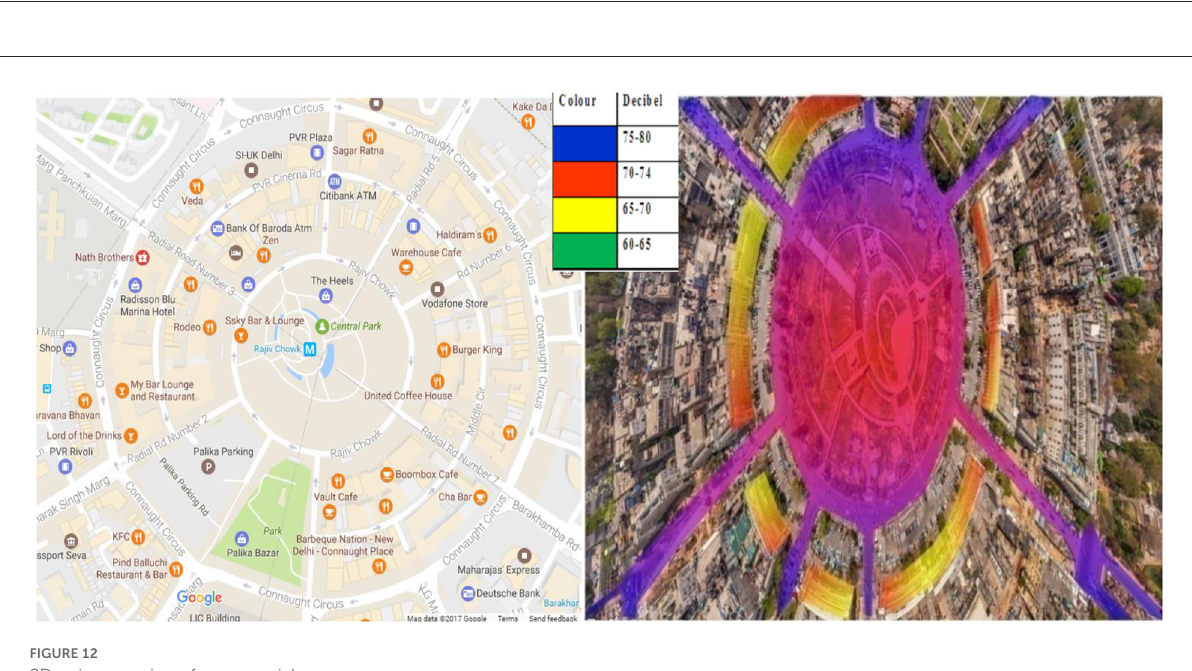
FIGURE12 2D noise mapping of commercial